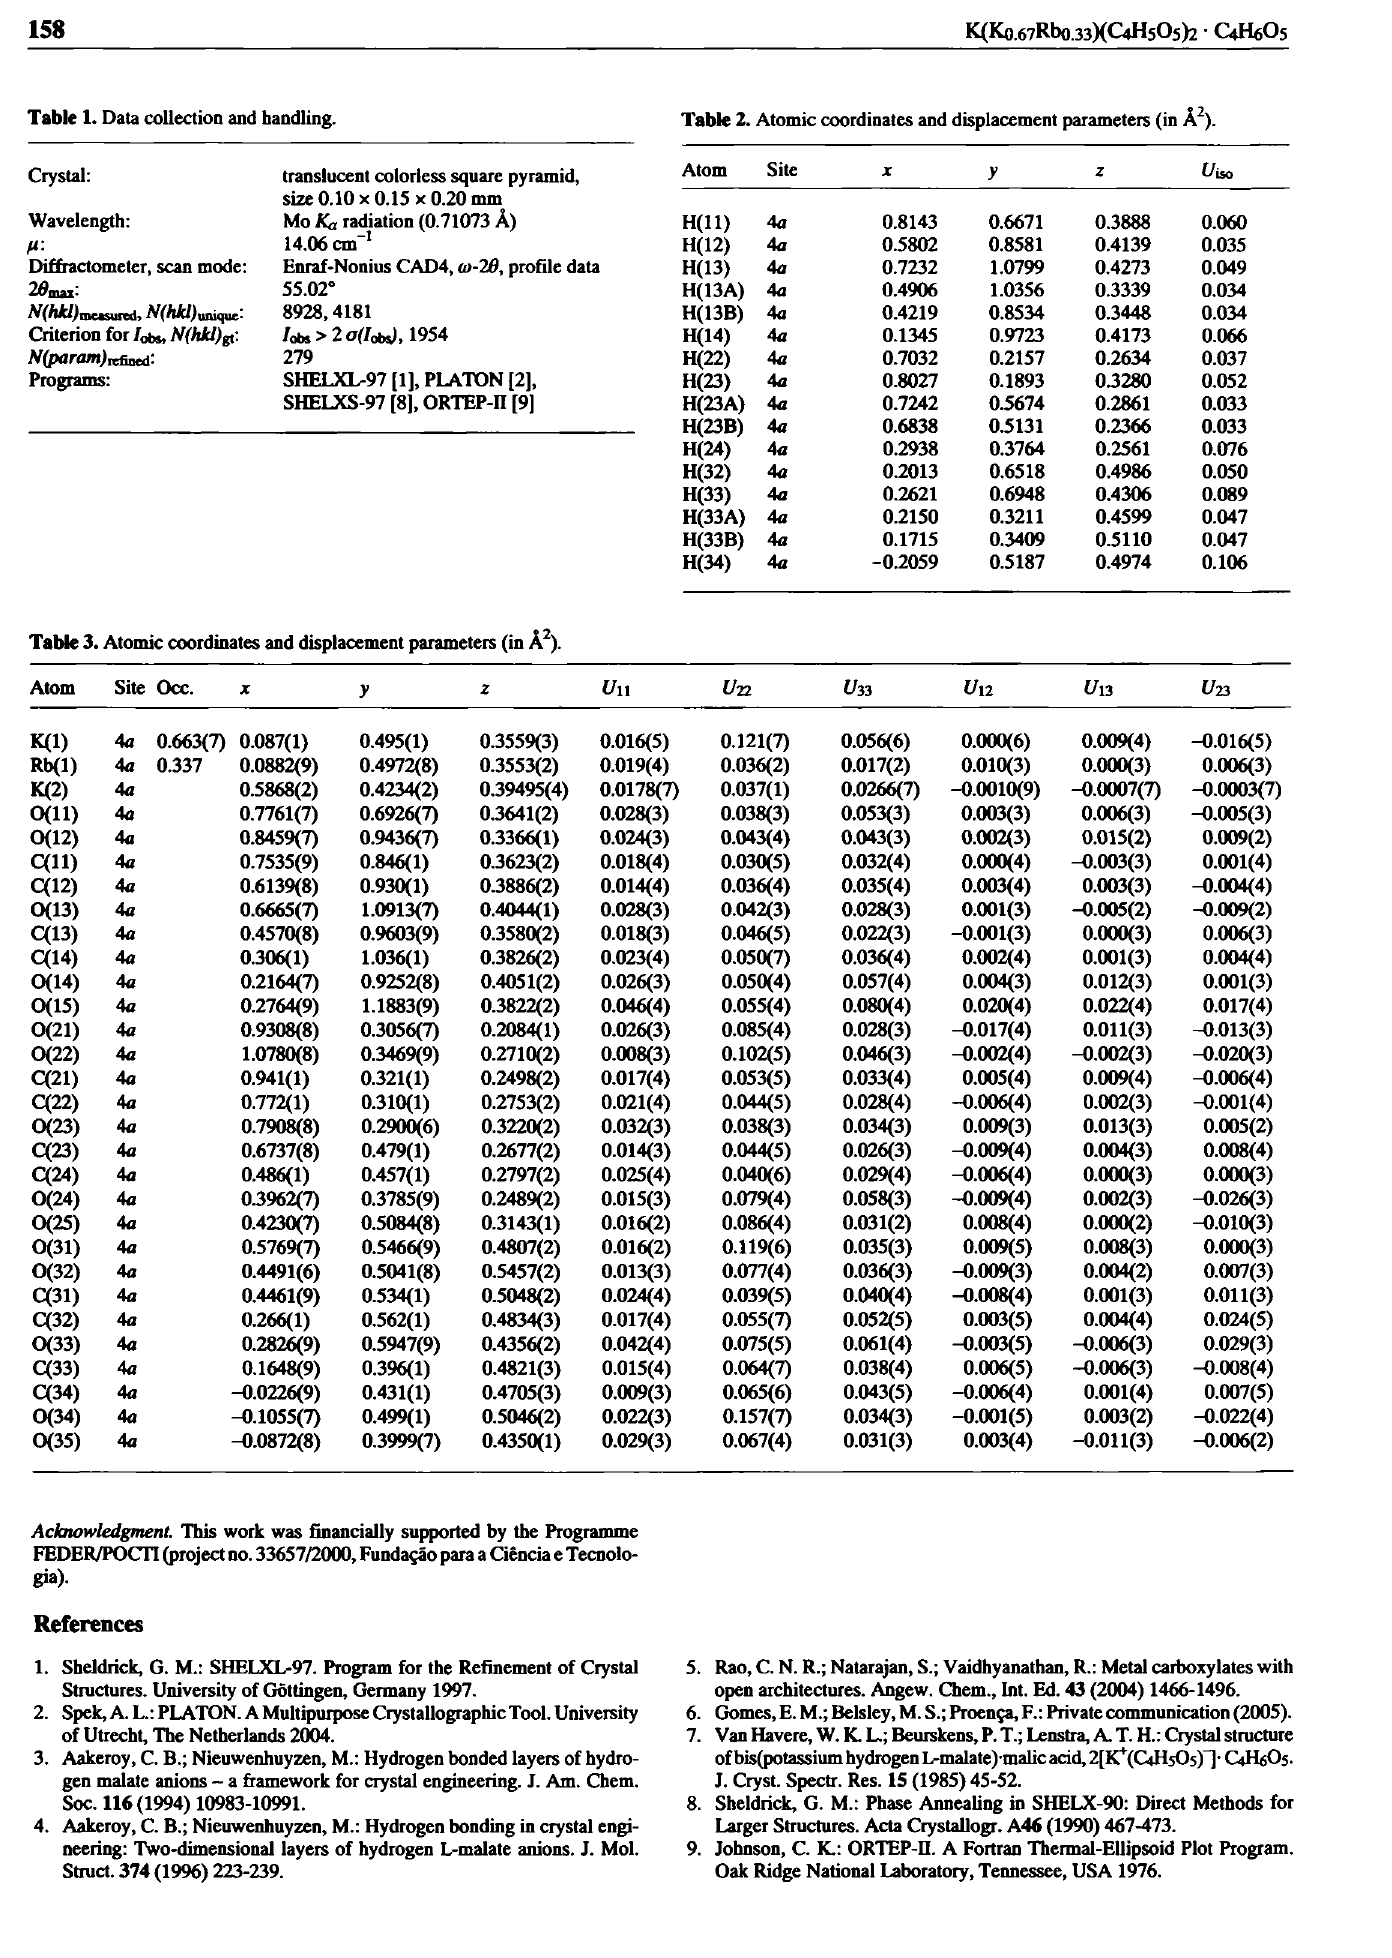
Table 1. Data collection and handling. Table 2. Atomic coordinates and displacement parameters (in Ä 2 ).